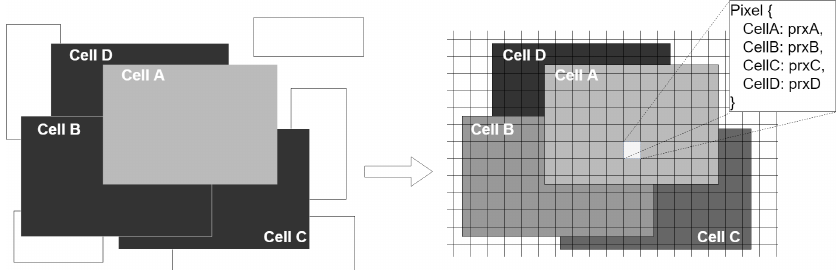
Figure 9. Illustration of the cell intersection module, to identify neighboring cells of A, and the world map creation module, identifying for each pixel the received signal levels of neighboring cells.